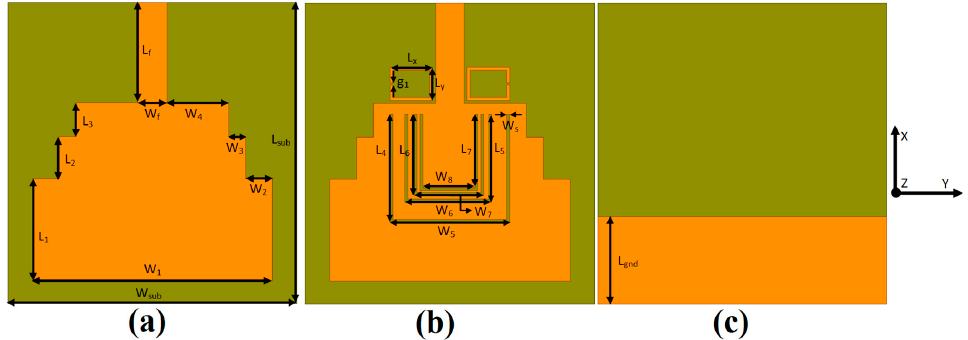
Figure 1. The geometry of ( a ) the reference antenna (front view); ( b ) the proposed antenna (front view); and ( c ) the reference and proposed antenna (rear view).